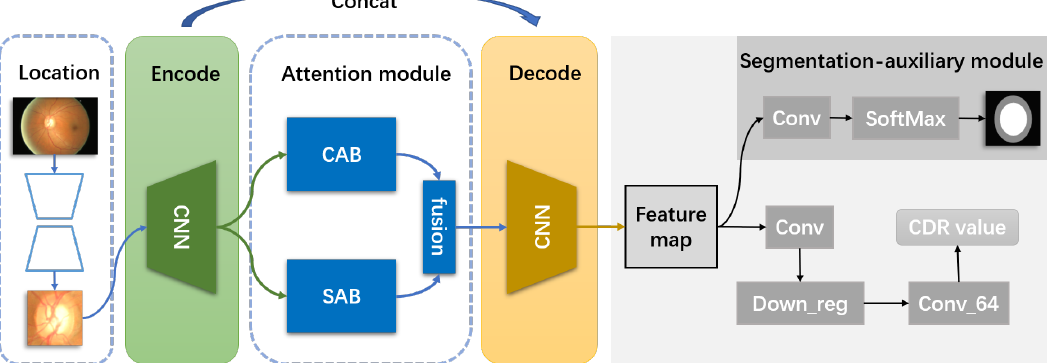
Figure 1. Overview of Channel and Spatial Attention Regression Network, which combines a deep convolution neural network (CNN) for cropping optic disc and optic cup areas, the encode, two parallel attention modules called channel attention block (CAB) and spatial attention block (SAB), the decode, and a multitask relationship learning module for cup-to-disc ratio number estimation. Here, the “conv” is denoted as convolutional layer, the “down_rep” represents three down-sampling layers and the “conv-64” means convolution layer with kernel size 64 ×